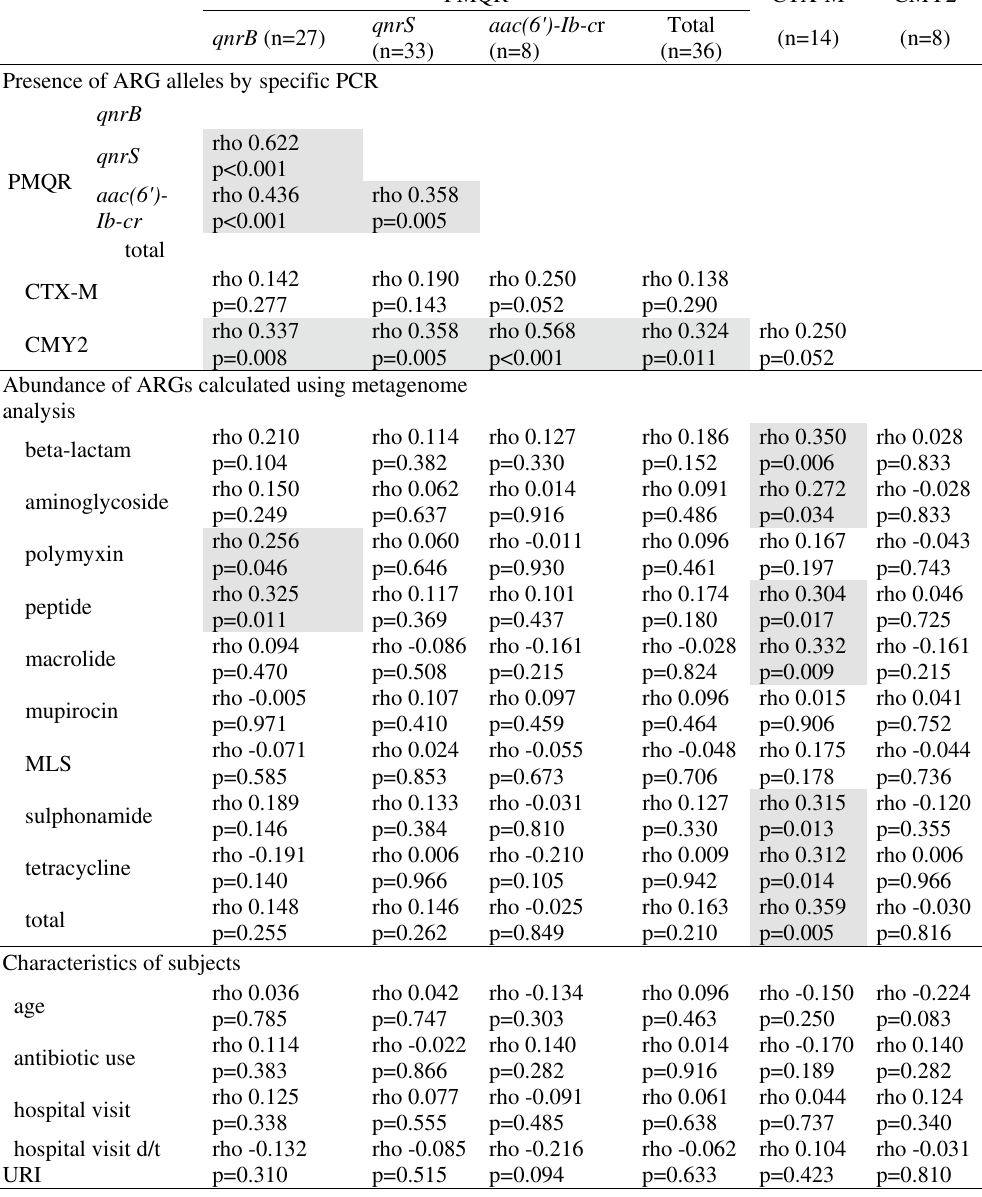
Figure 3. Associated presence of CTX-M, plasmid-mediated AmpC, and PMQR genes and their relationship with the abundance of ARGs and medical history. The shaded box represents a statistically significant relationship between two variables. PMQR plasmid-mediated quinolone resistance alleles, MLS macrolides- lincosamides-streptogramins shared, URI upper respiratory